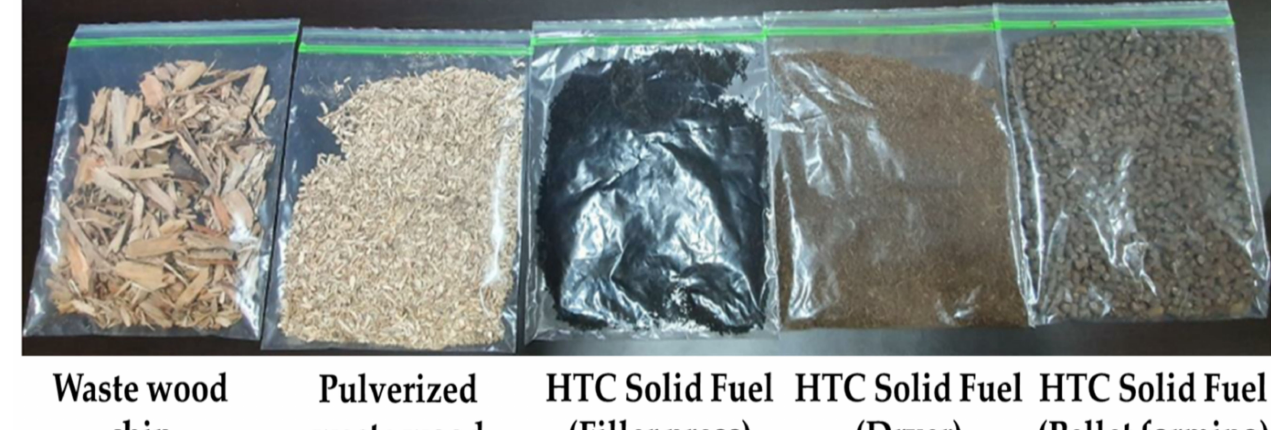
Figure 3. HTC solid fuel according to the pilot plant